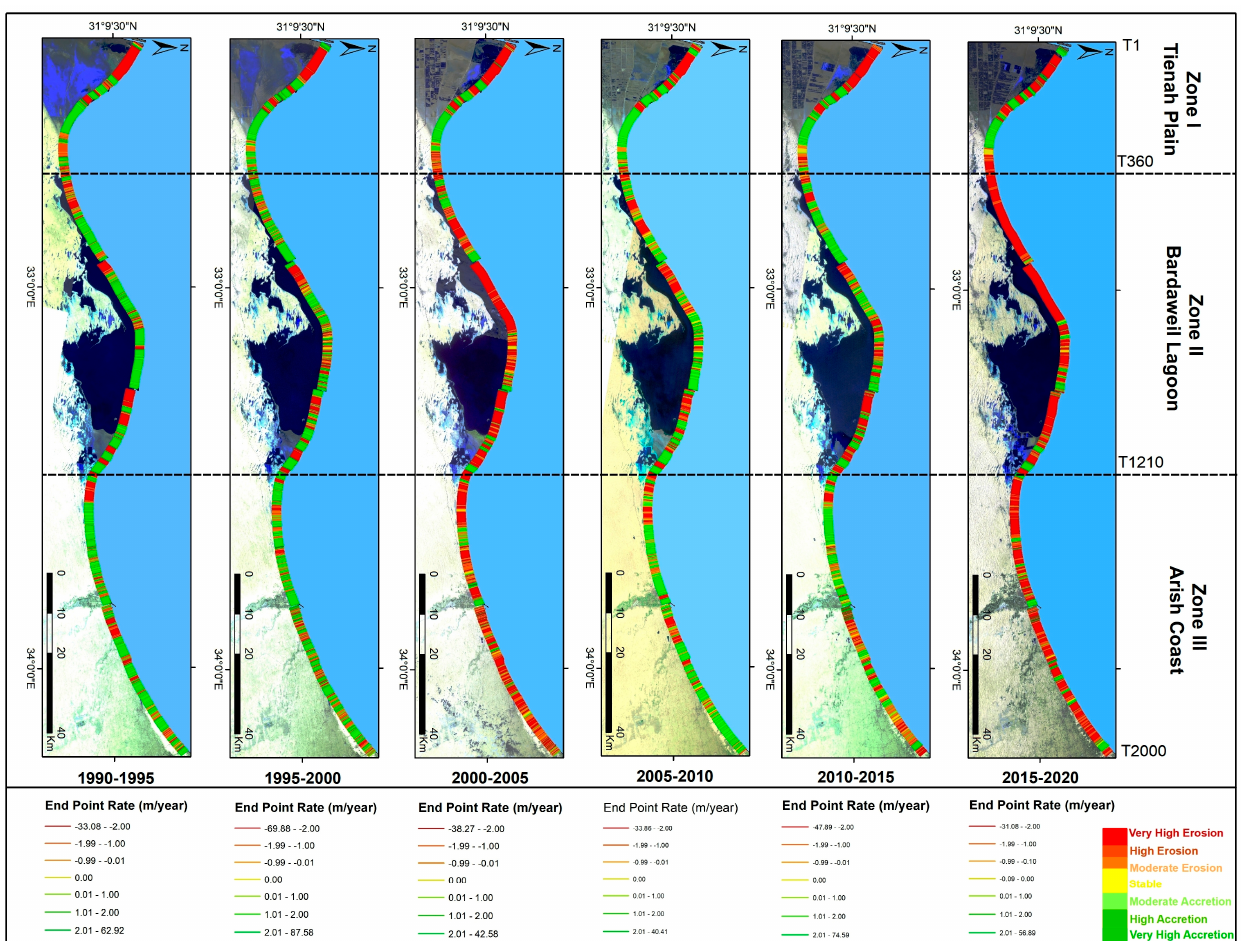
Figure 8. EPR of coastline change between 1990 and